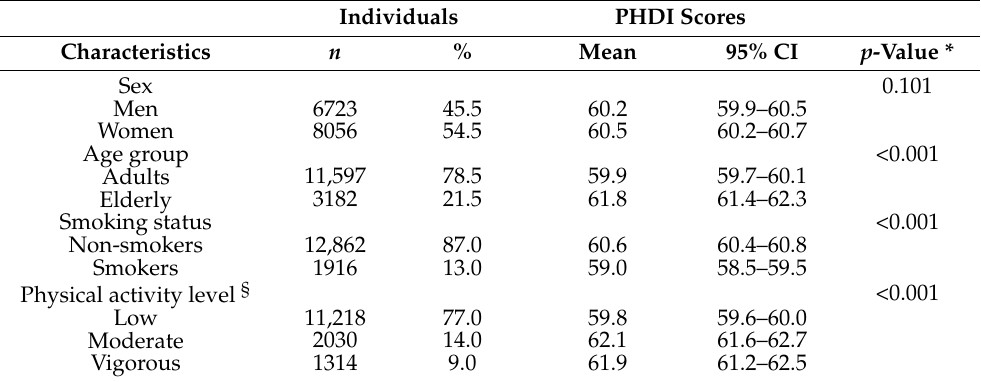
Table 4. Characteristics of the individuals included in the study and their PHDI scores. ELSA-Brasil,